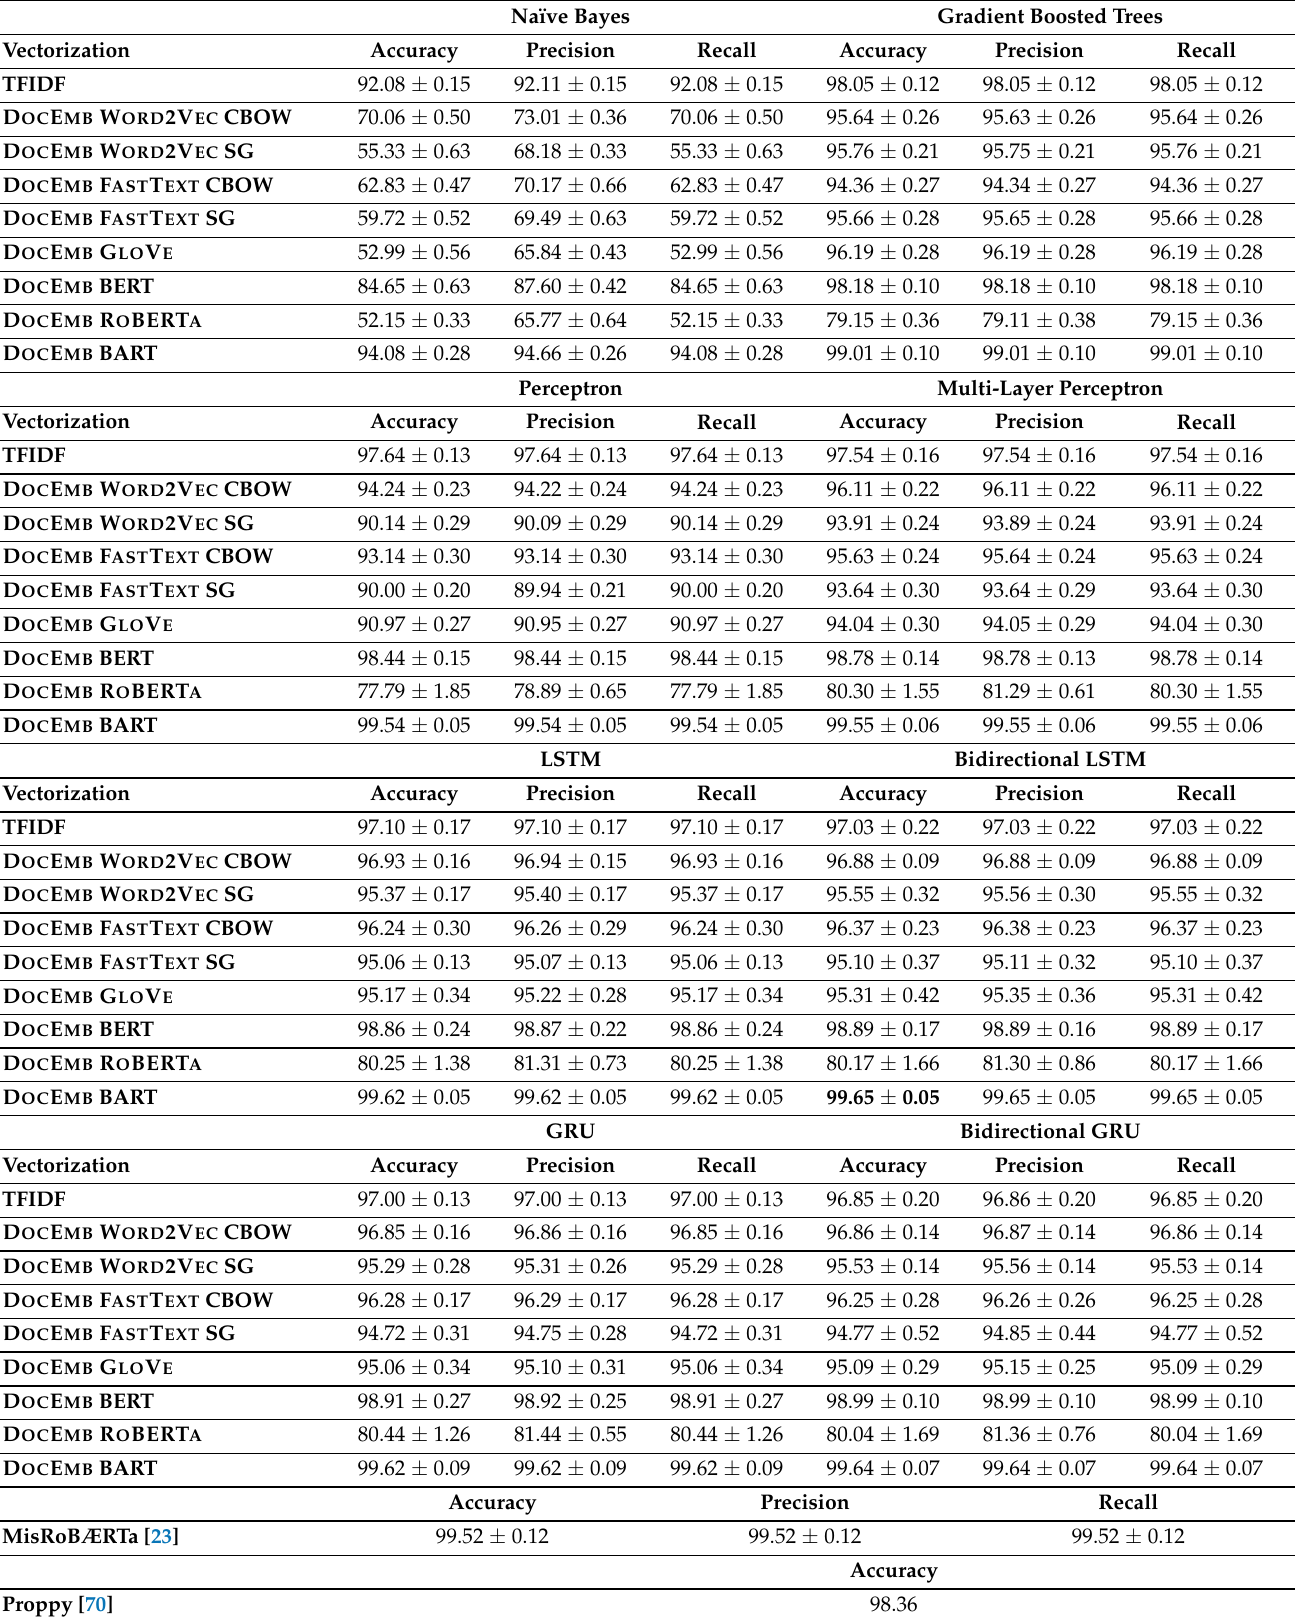
Table 7. Fake news detection results on TSHP-17 dataset as presented in Rashkin et al. [53] and Barrón- Cedeño et al.